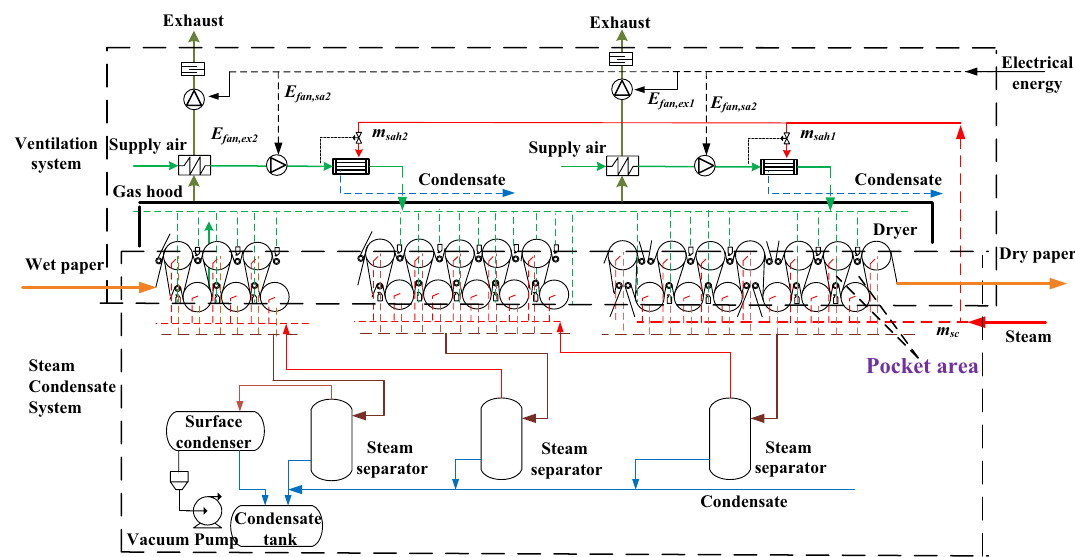
Fig. 1 Schematic diagram of a typical ventilation system